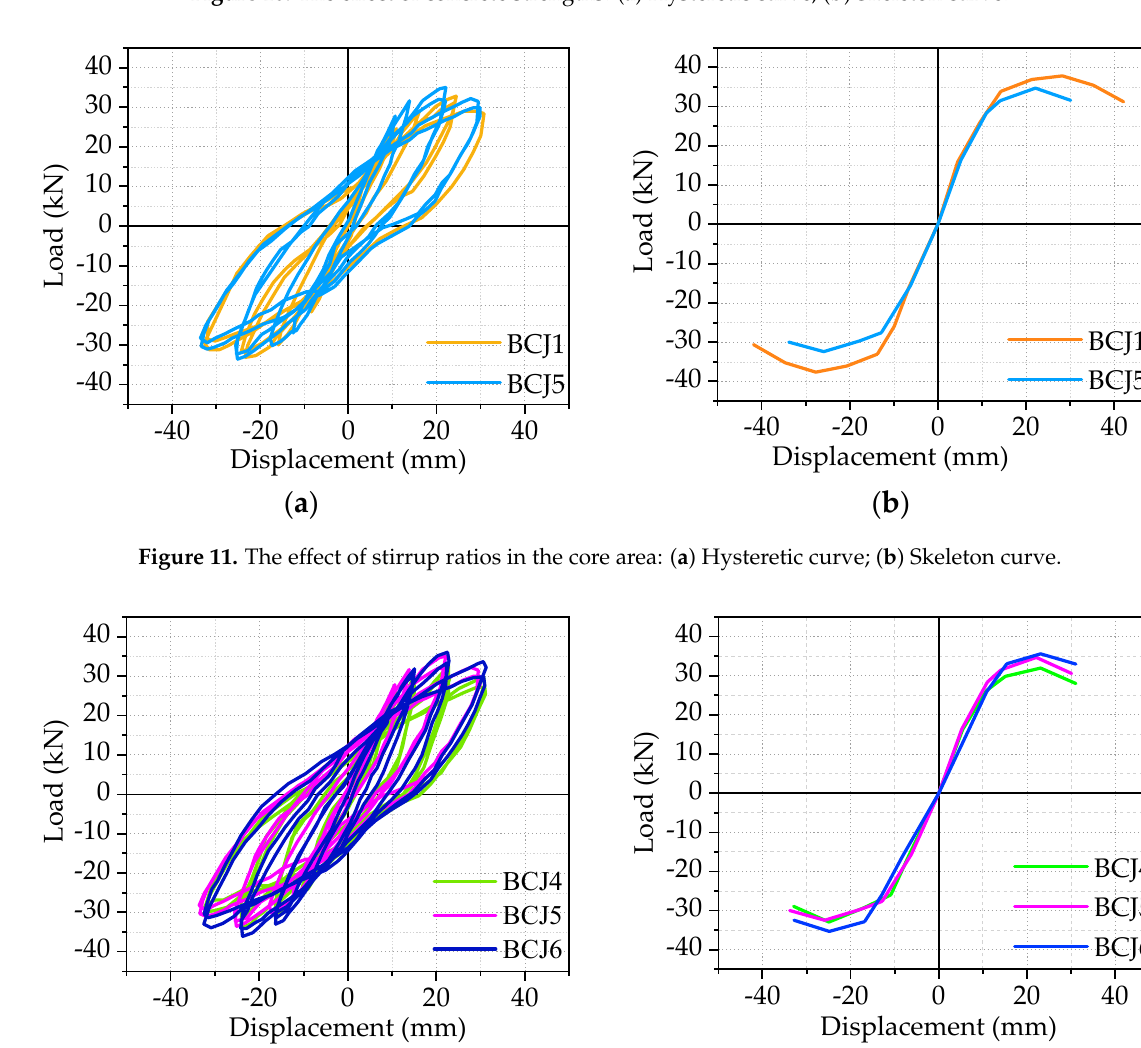
Figure 10. The effect of concrete strengths: ( a ) Hysteretic curve; ( b ) Skeleton curve.